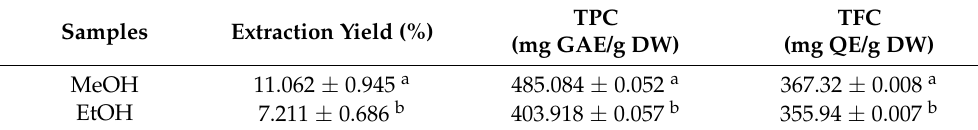
Table 2. Total phenolic and flavonoid contents of methanolic and ethanolic extracts of A. foeniculum AdB; means ±